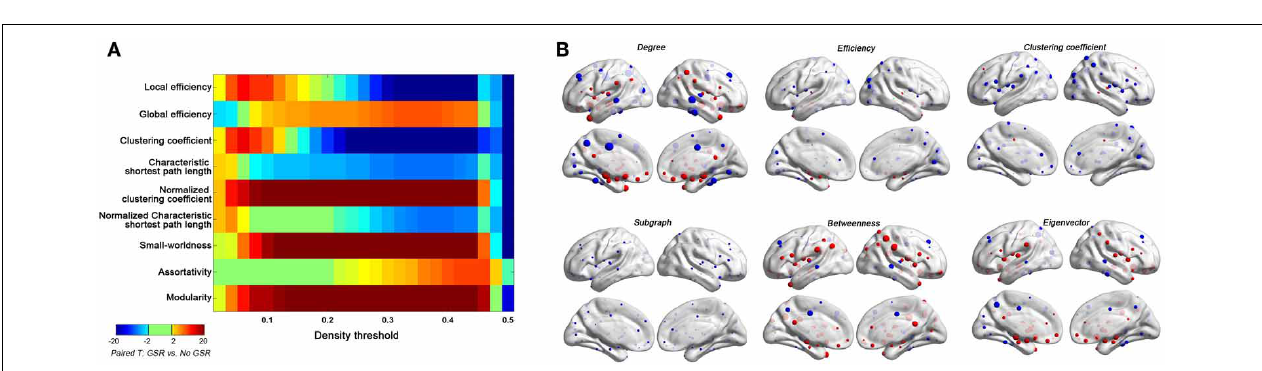
sphere ROIs, B : Craddock’s 200 ROIs), weighted graph based on AAL atlas (C) , and Beijing dataset based on AAL atlas (D) . Results without GSR were shaded in green and with GSR were shaded in pink.